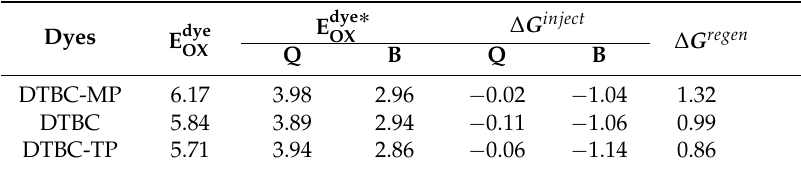
Table 3. The calculated oxidized potential of ground state ( E dye the free energy variation of electron injection ( ∆ G inject ) and dye regeneration ( ∆ G regen ) for DTBC-MP, DTBC, and DTBC-TP (all of the quantities are giving in